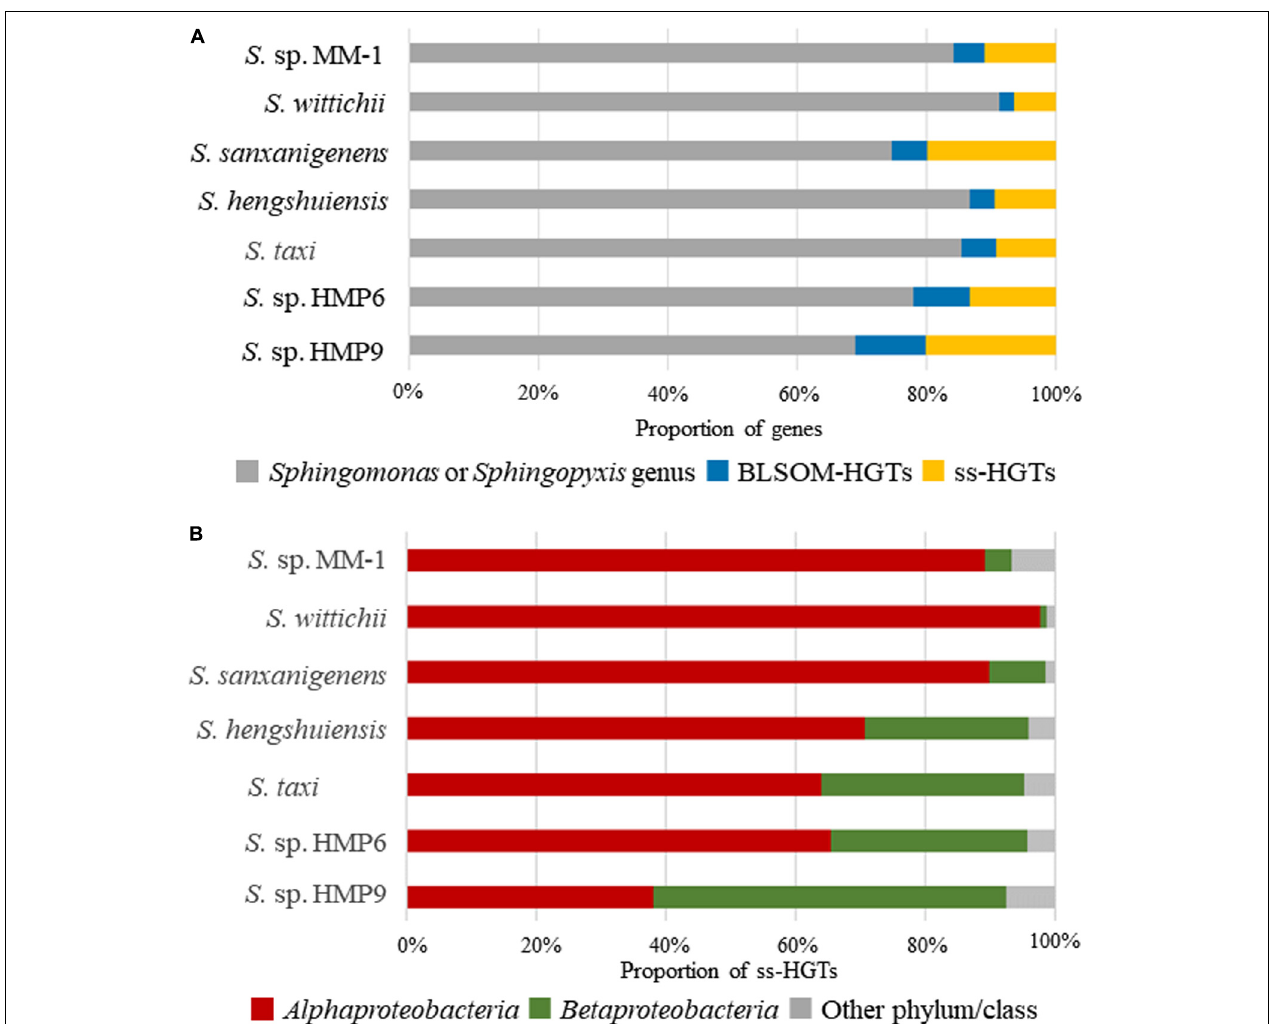
FIGURE 4 | Proportion of HGT candidate genes in the Sphingomonas strains assigned by BLSOM and BBH. (A) Proportion of HGT candidate genes. Gray ( (cid:4) ): proportion of genes assigned to Sphingomonas or Sphingopyxis genus; blue ( (cid:4) ): BLSOM-HGTs; orange ( (cid:4) ): strain-specific HGT candidate genes (ss-HGTs). (B) Proportion of ss-HGTs at phylum/class level through BBH analysis from BLSOM-HGTs. Brown ( (cid:4) ): Alphaproteobacteria ; dark green ( (cid:4) ): Betaproteobacteria ; gray ( (cid:4) ): other